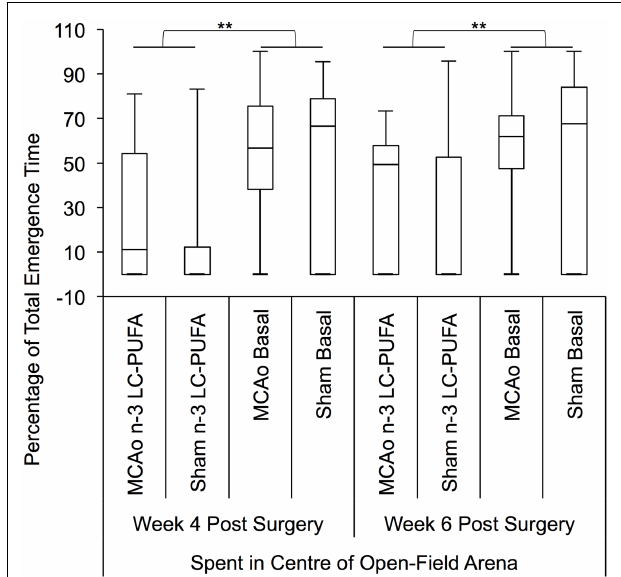
FIGURE 9 | Box plots showing significant post hoc differences in time spent exploring novel object exploration between diet and surgery conditions both at 4 and 6weeks post-surgery .Visual inspection of this figure indicates that at both time points sham surgery-operated animals supplemented with n -3-LC-PUFA diet spent more time exploring the novel object than sham operated basal diet fed animals. MCAo surgery-operated animals supplemented with n -3-LC-PUFA diet appear to have spent slightly more time exploring the novel object than MCAo operated basal diet fed animals. MCAo, middle cerebral artery occlusion surgery condition; Sham, Sham surgery condition; Basal, basal diet fed rats; n